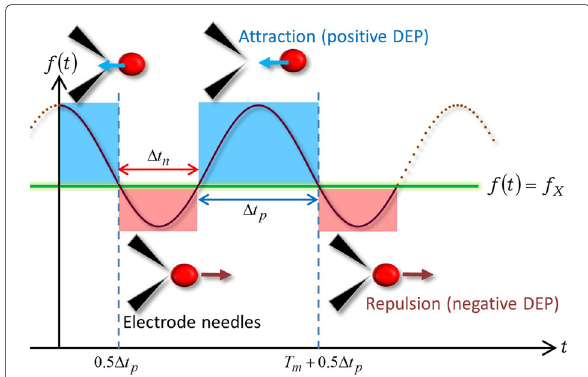
Fig. 4 Force direction related to the frequency modulation. An illustration of the periodic U-turns due to the FM wave with its time-dependent frequency of f ( t ) covering a crossover frequency f